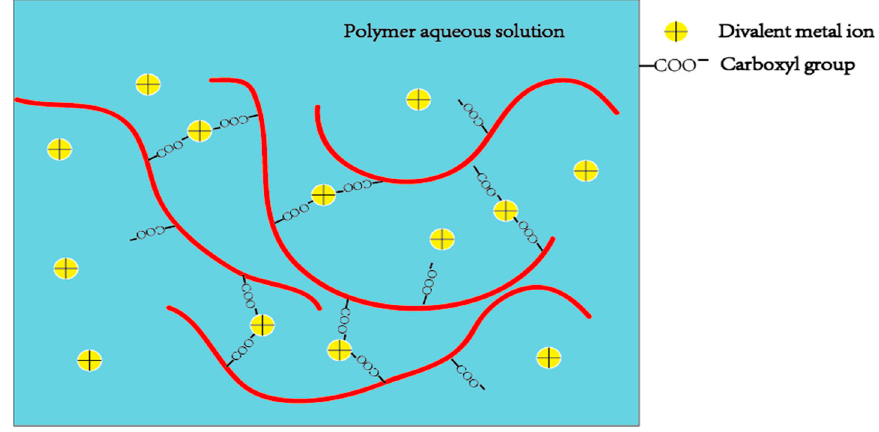
Figure 13. Solubility product balance among –COO − groups and divalent metal ions in a polymer solution.